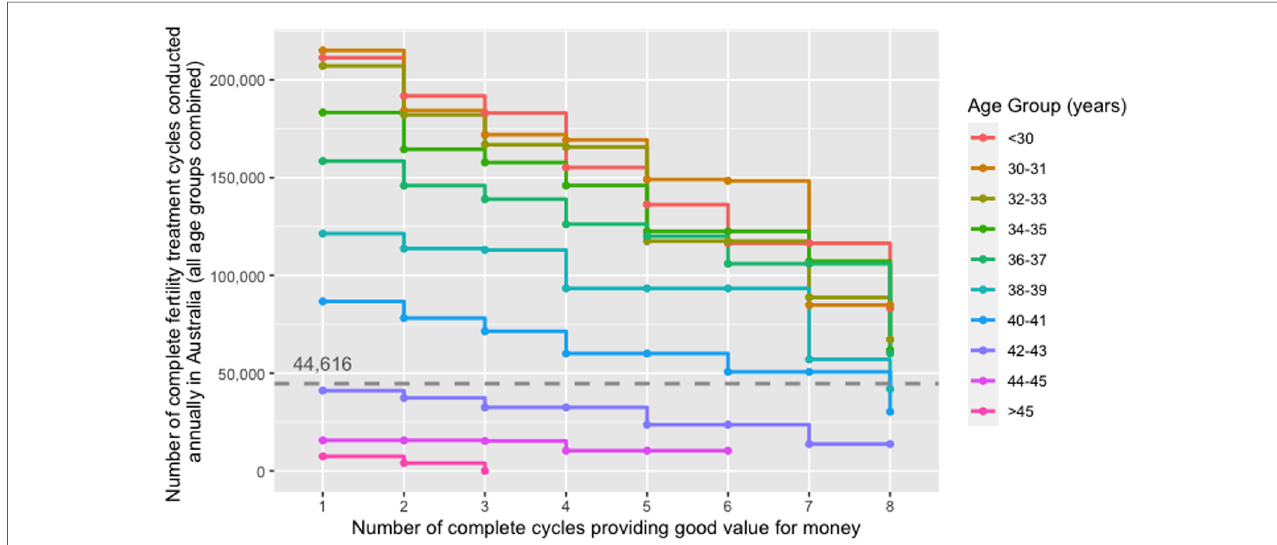
FIGURE 4 Threshold number of complete fertility treatment cycles conducted annually in Australia beyond which treatment cycles did not provide good value for money from a taxpayer perspective strati fi ed by age group; scenario where only those women who reached the oocyte pick-up procedure were considered. The dashed line indicates the number of complete fertility treatment cycles conducted in the baseline year (i.e., 44,616 complete fertility treatment cycles in 2018). The threshold values for the number of complete fertility treatment cycles conducted annually represent the maximum number of cycles that